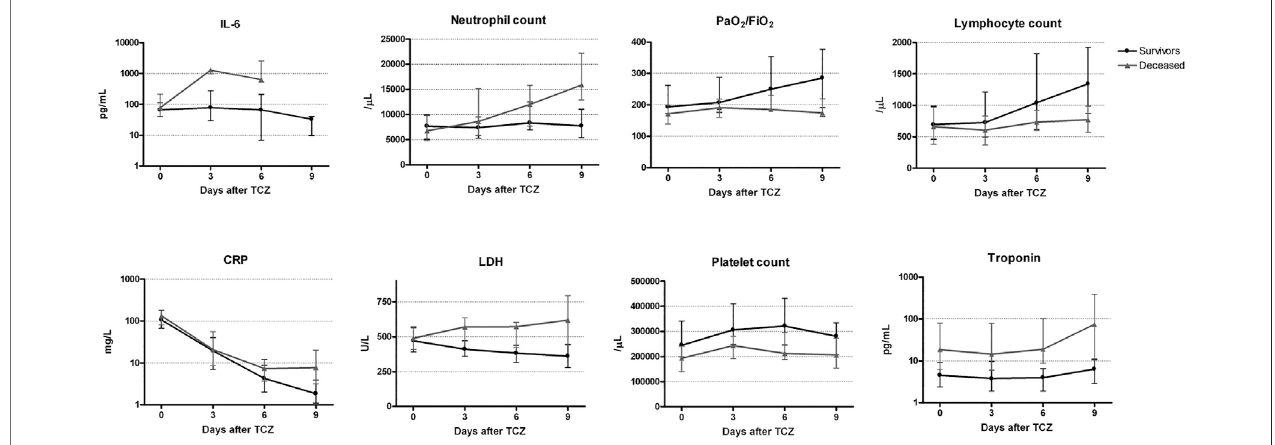
FIGURE 2 | Changes in laboratory parameters after tocilizumab administration and their comparison between survivors and deceased patient. LDH: Lactate dehydrogenase; CRP: C-reactiveprotein; IL-6: interleukin-6. Values are represented as median (circle) and interquartile range (25th and 75th percentiles error bars).